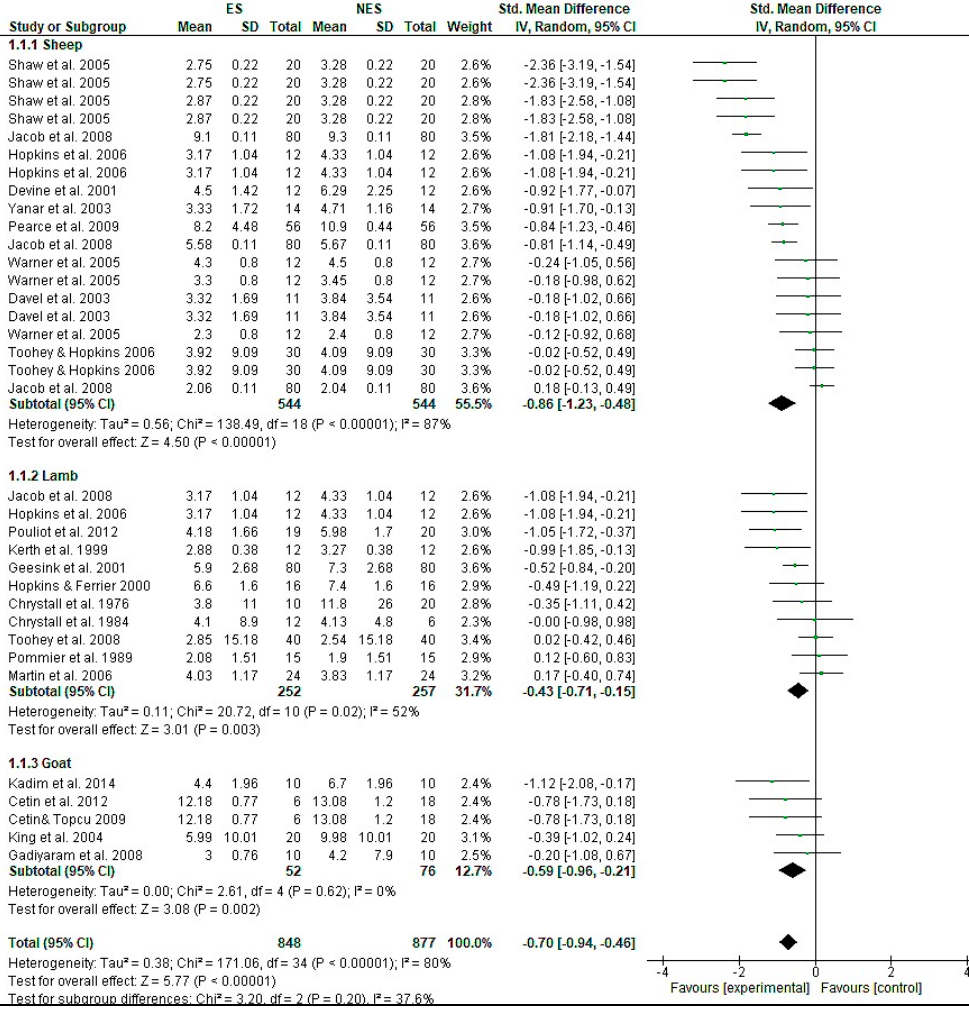
Figure 1. Forest plot of Warner–Bratzler shear force (kg) responses in electrical stimulation studies. A forest plot was used for the graphical display of the estimated results/effect size of the effect of electrical stimulation on Warner–Bratzler shear force, using the standardized mean difference (standardized using the z ‐ statistic) and 95% confidence interval. The weights that each study contributed are presented. The solid vertical line represents a mean difference of zero or no effect. Points to the left of the line represent a reduction in Warner–Bratzler shear force, while points to the right of the line indicate an increase. The upper and lower limit of the lines connected to the square (effect size) denotes the 95% confidence interval for the effect size. The overall effects size for all species with 95% confidence interval is indicated by the diamond at the bottom. This effect was heterogenous, as indicated by the I 2 of 80.0%.